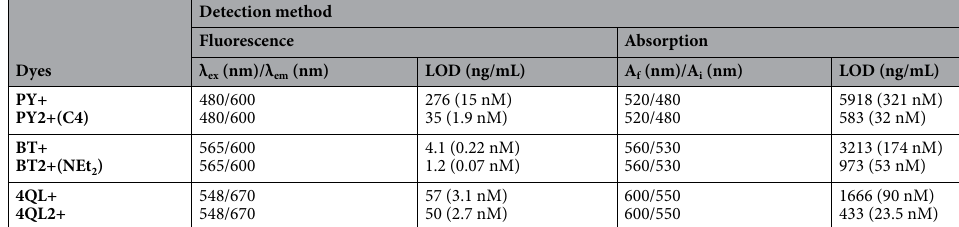
Table 3. Comparison of the limit of detection of cationic styryl dyes for the determination of dsDNA by fluorescence and UV–visible spectrophotometry. Conditions: [Dye] = 2 μM, [DNA (in bp)] = 0.3–3 μM; all measurements were performed in 10 mM sodium phosphate buffer pH